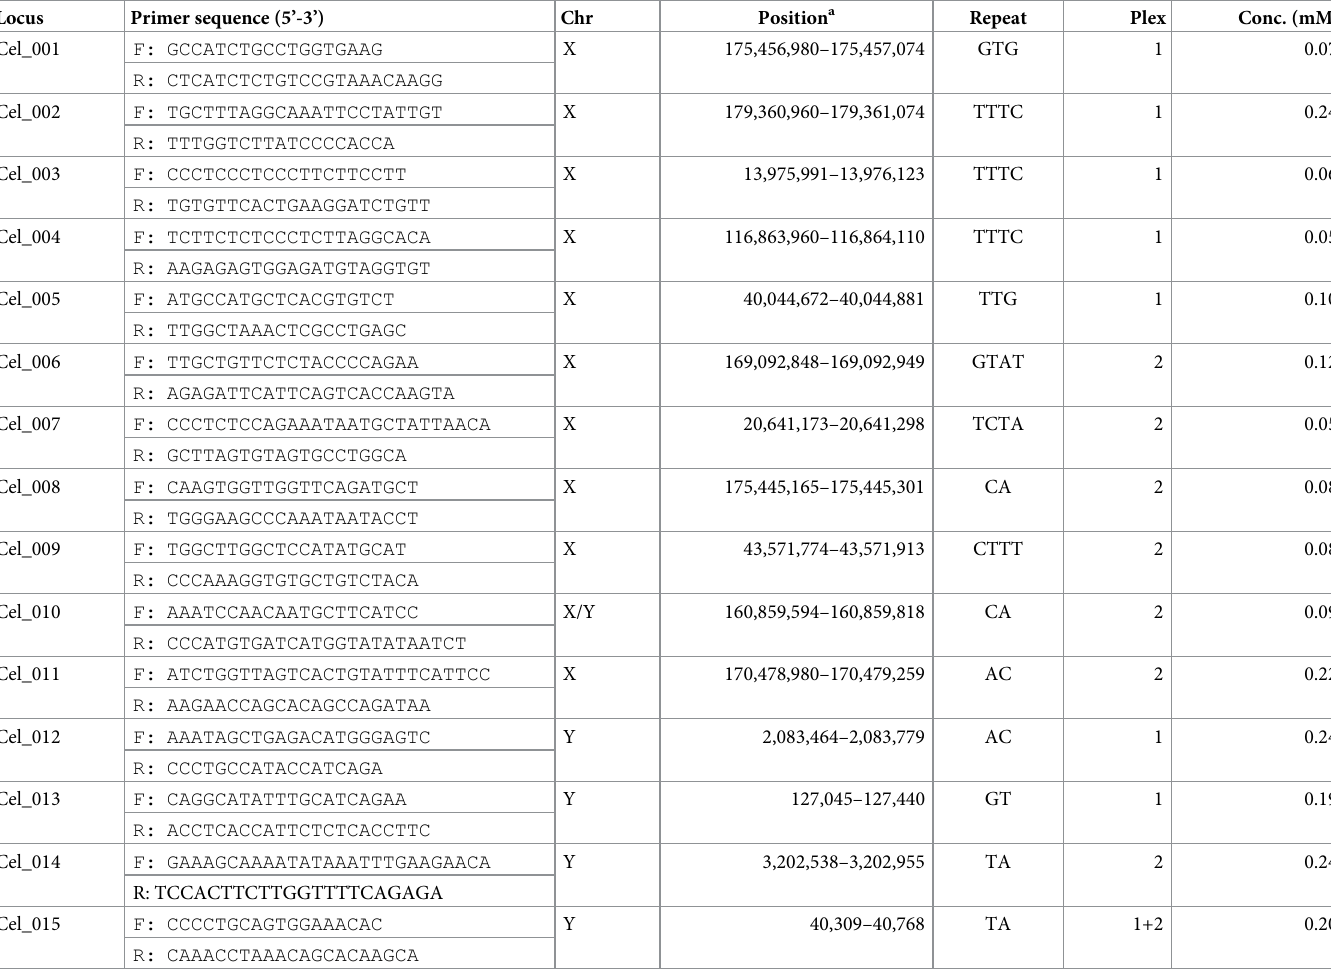
Table 2. Characterization of 15 microsatellites/STRs located on red deer sex chromosomes. Locus Primer sequence